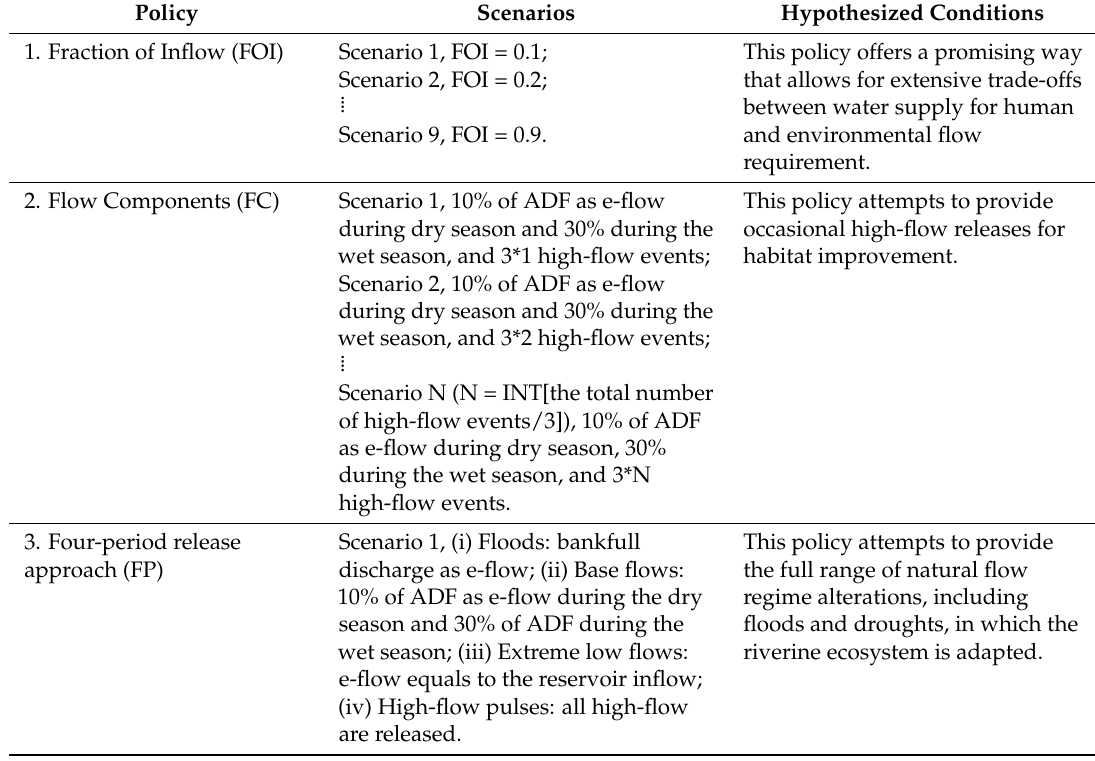
Table 1. Detailed information of the different environmental flow policies and related scenarios.